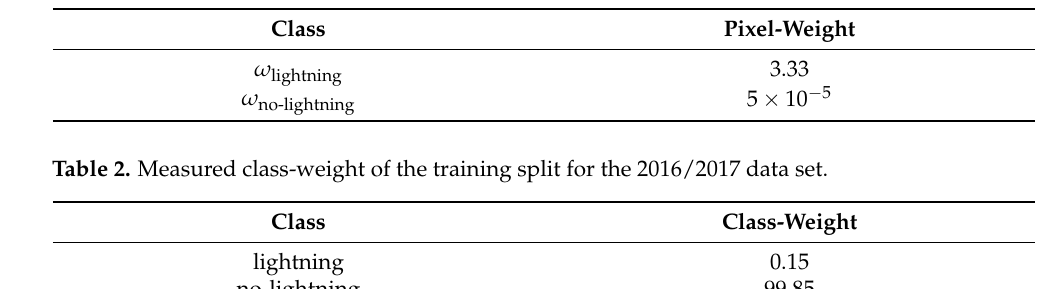
Table 1. Computed pixel-weights of the training split for the 2016/2017 data set, based on class- weights shown in Table 2 and Equation (7).